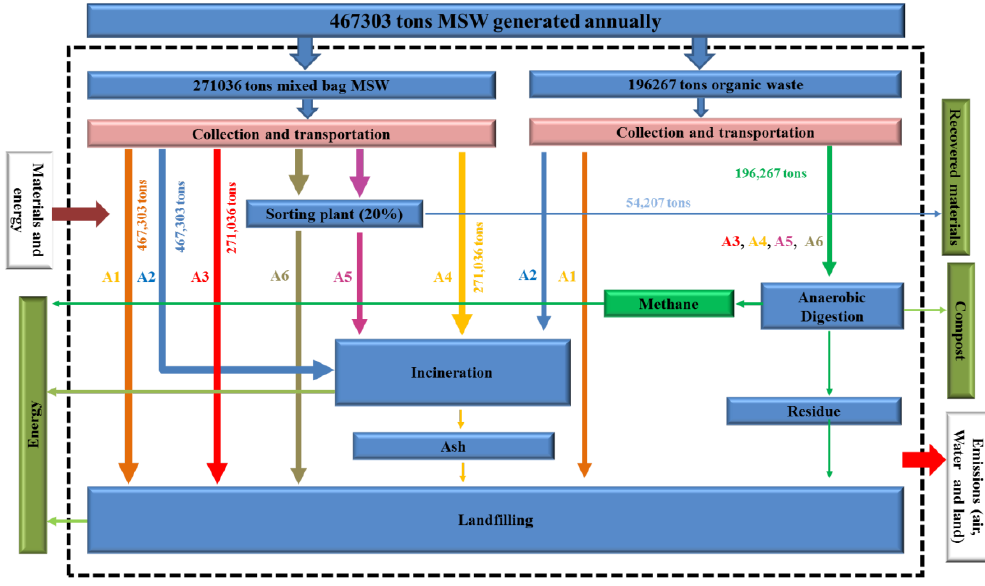
Figure 2. Life cycle assessment (LCA) system boundaries.